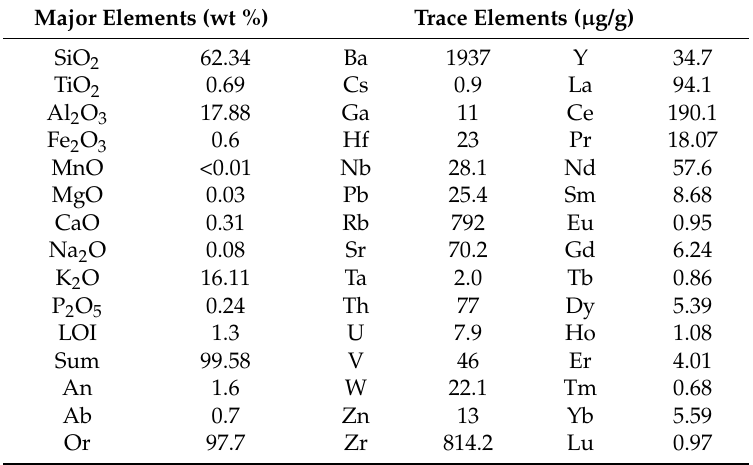
Table 2. Composition of K-feldspar cement. Analyses were performed at ACMELabs